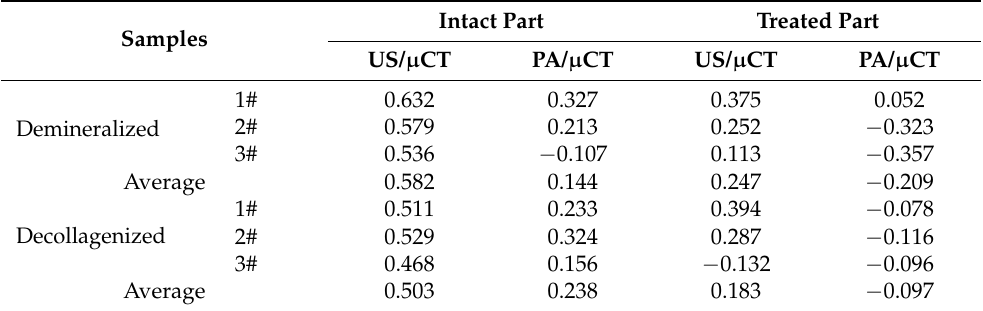
Figure 4. PA and US AIB value variation histogram before and aftertreatment for intact and treated parts of the bone samples. Table 1. The correlation coefficient between US or PA AIB and microcomputed tomography ( µ CT) in the treated and intact parts of the